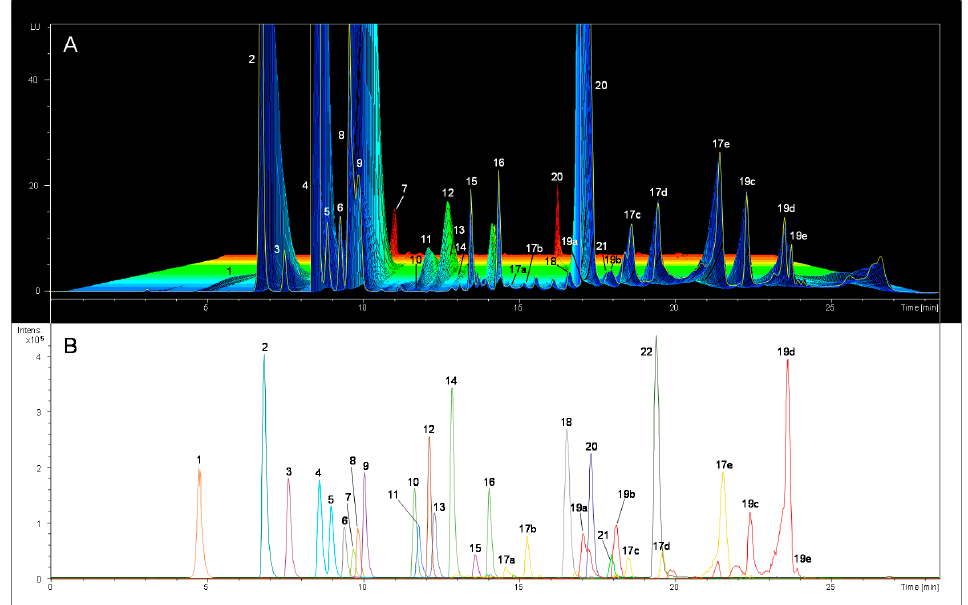
Figure 1. ( A ) 3D-plot of a fortified extra-VOO extract with eighteen phenolic compounds at a final concentration level of 10 μ g·mL − 1 , when excitation wavelength is set at 285 nm and the zero order emission spectra is recorded; ( B ) Extracted ion chromatograms (EICs) of the known phenolic compounds for the same fortified extract as in ( A ), obtained in electrospray ionization–ion trap MS (ESI-IT MS) detector (using negative ionization mode). Peak identification numbers: (1) Gallic acid (Gal); (2) HTY; (3) 3,4-dihydroxyphenylacetic acid (DOPAC) (used as internal standard (IS)); (4) TY; (5) 4-hydroxybenzoic acid (4-HBA); (6) 4-hydroxyphenylacetic (4-HPA); (7) vanillic acid (Van); (8) syringic acid (Syr); (9) homovanillic acid (Hmvan); (10) p -coumaric acid ( p -Cou); (11) vanillin (Val); (12) sinapic acid (Sin); (13) ferulic acid (Fer); (14) m -coumaric acid ( m -Cou); (15) oleuropein (Ole); (16) o -coumaric acid ( o -Cou); (17) oleuropein aglycon (OleAgly) and isomers; (18) luteolin (Lut); (19) ligstroside aglycon (LigAgly) and isomers; (20) (+)-pinoresinol (Pin); (21) acetoxypinoresinol (AcPin); and (22) Apig. As far as the different isomers of OleAgly and LigAgly are concerned, they are identified by adding a letter (a–e) to the number assigned for the main